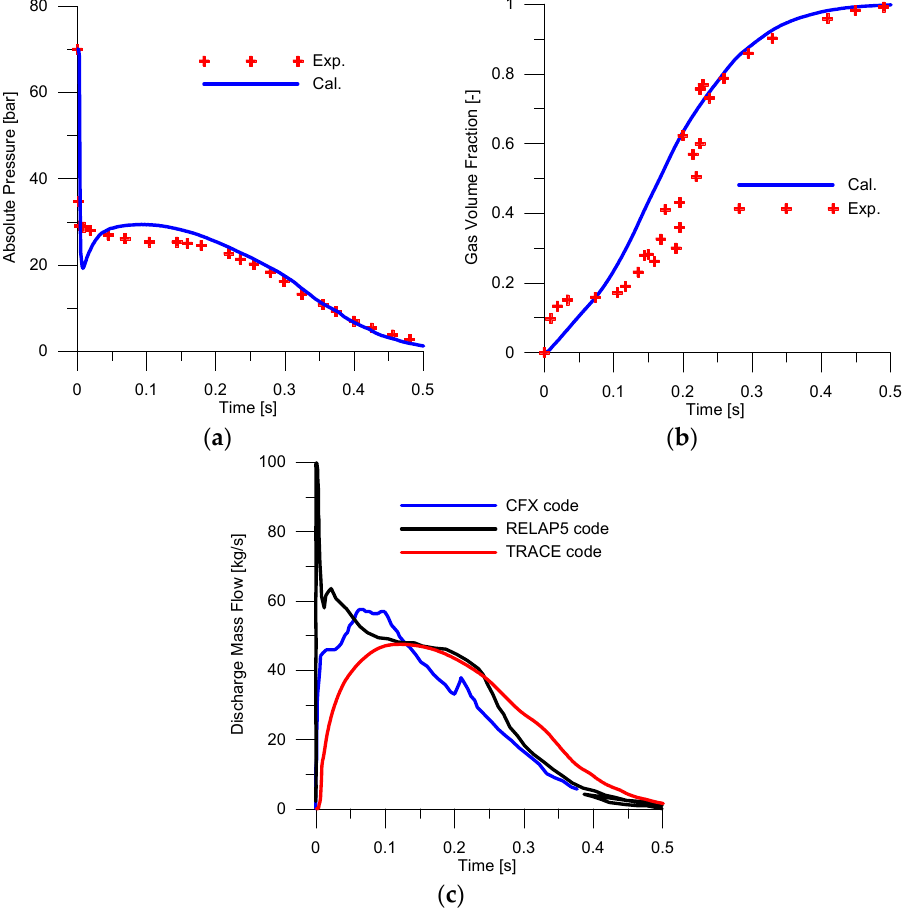
Figure 2. Evolution of flow parameters at x = 1.469 m after the disc burst: ( a ) absolute pressure; ( b ) void fraction; ( c ) discharged mass flow rate change with the time.